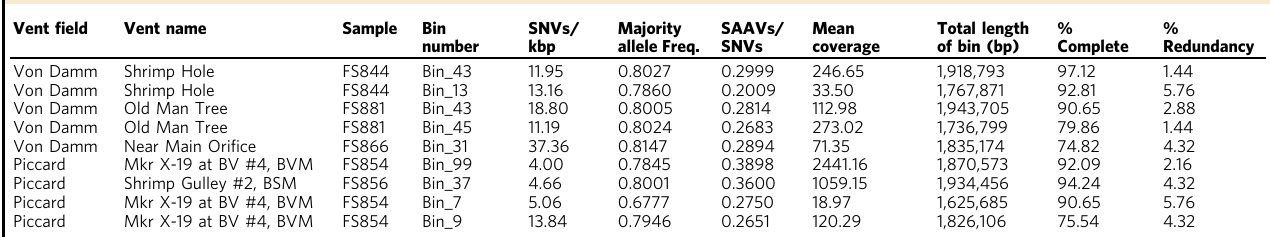
Table 2 Sulfurovum bins identi fi ed in all metagenomic samples Vent fi